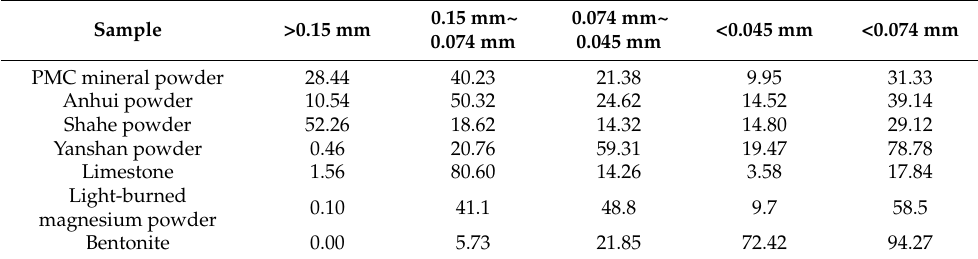
Table 3. Particle size distribution of mineral